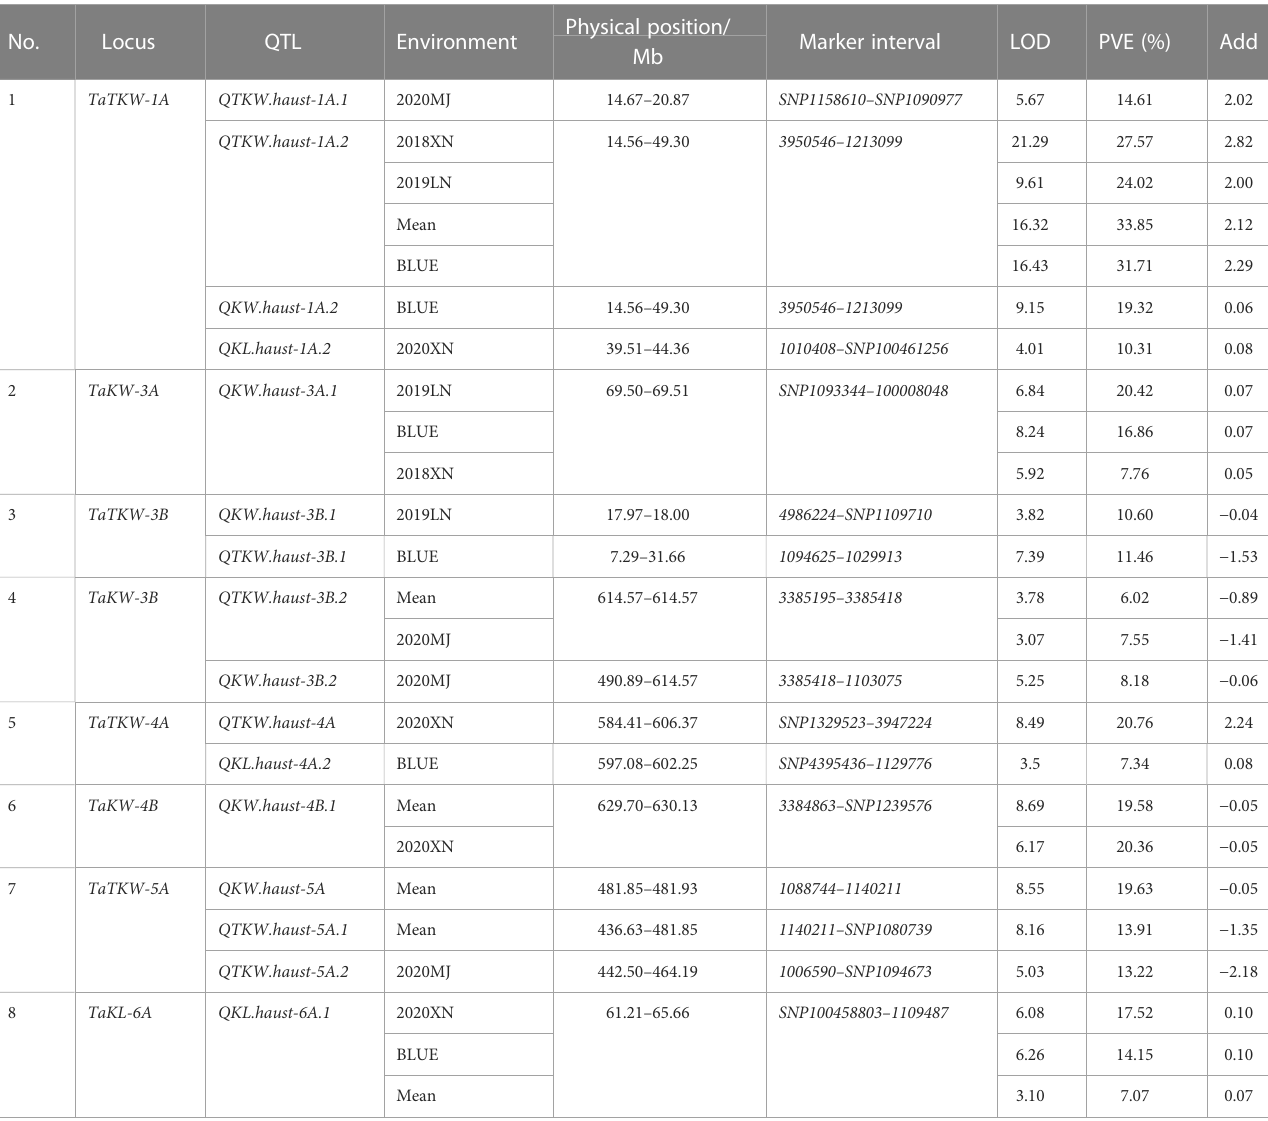
TABLE 2 The stable QTL clusters in the Avocet/Chilero RIL